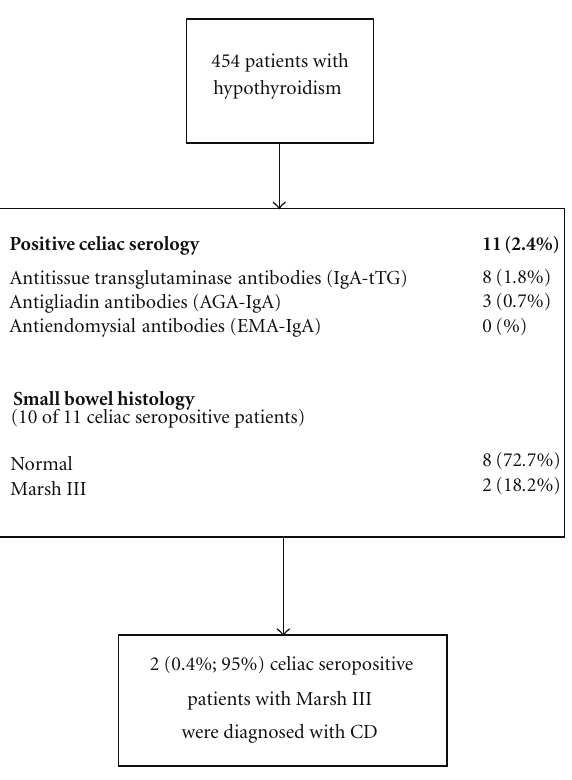
Figure 1: Flow diagram of patient recruitment and